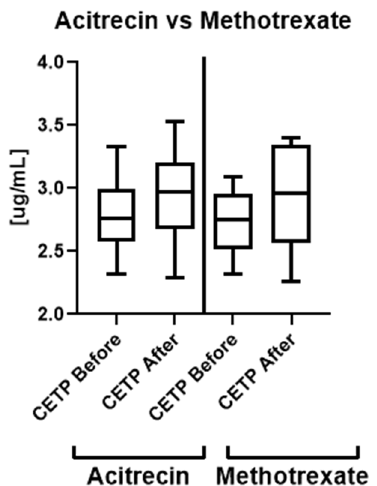
Figure 3. Concentrations of CETP in patients before and after the treatment with acitretin and methotrexate.